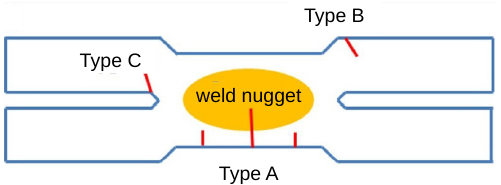
Figure 1. Categories of LME cracks by AWS